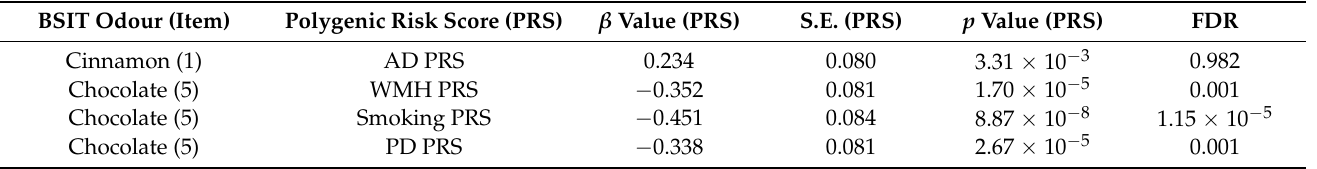
Table 5. FDR significant and suggestive ( p -value < 0.05) associations observed between polygenic risk scores for Alzheimer’s Disease (AD), white matter hyperintensities (WMH), smoking, Parkinson’s Disease (PD), and individual BSIT